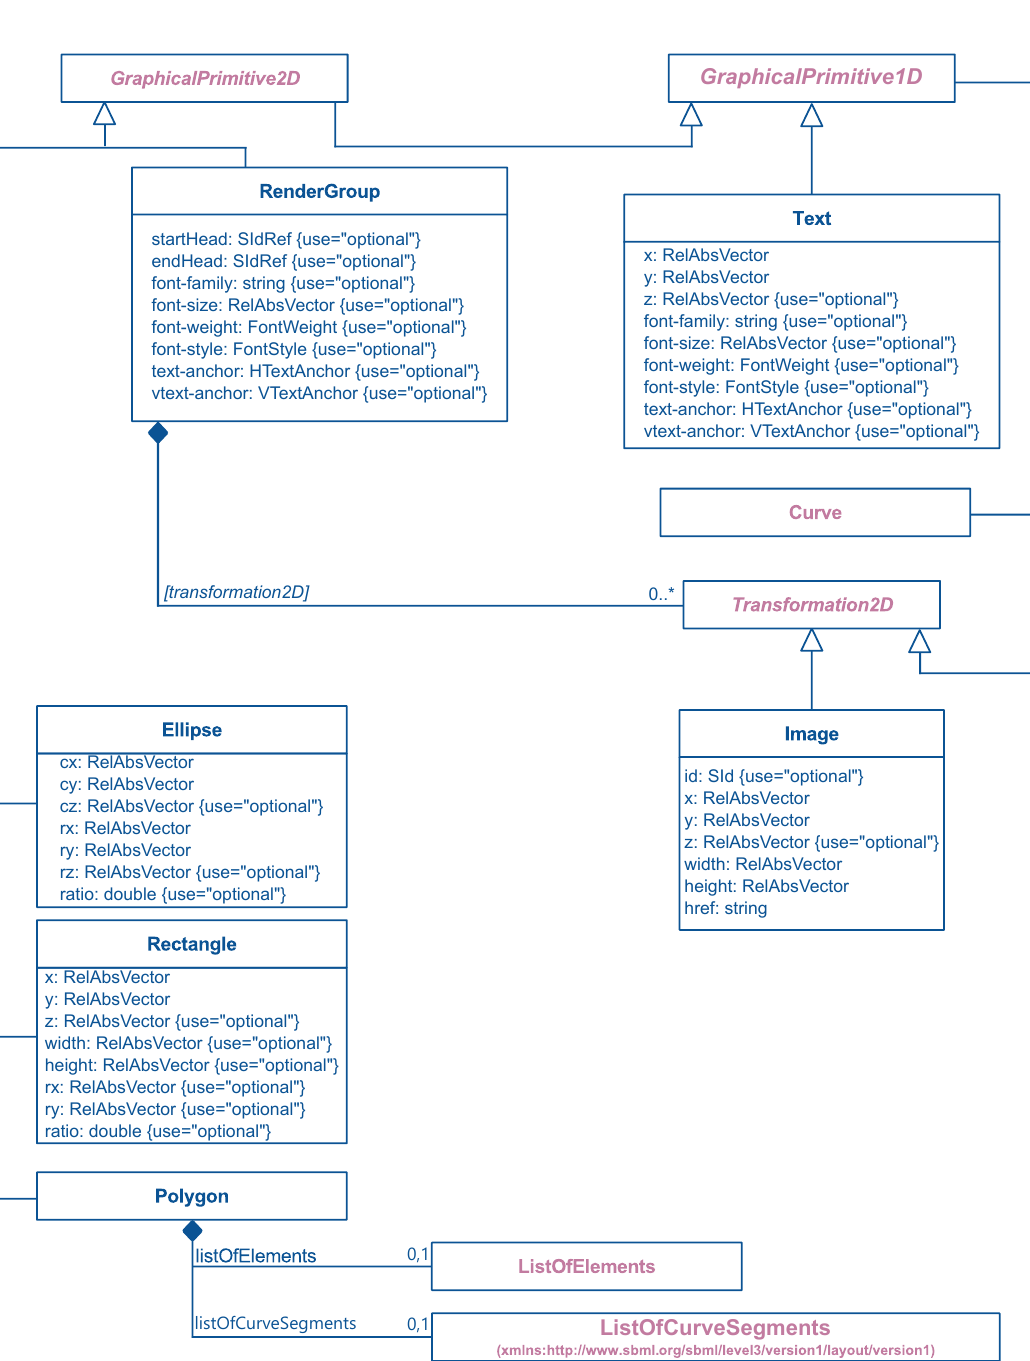
Section 3 Package syntax and